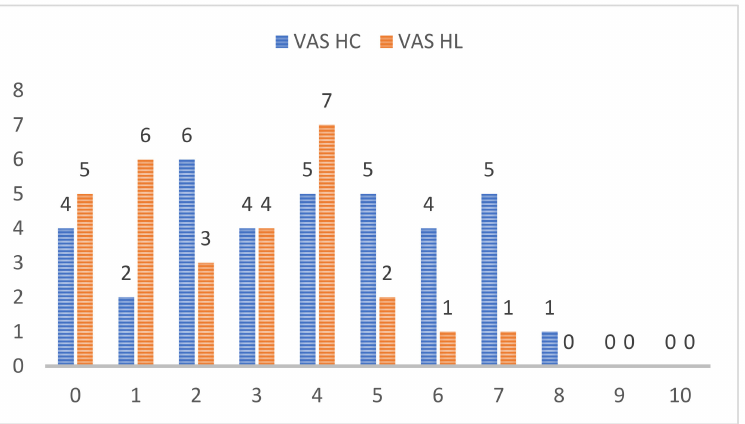
Figure 1. VAS score value reported by the subjects 24 h after applying the orthodontic